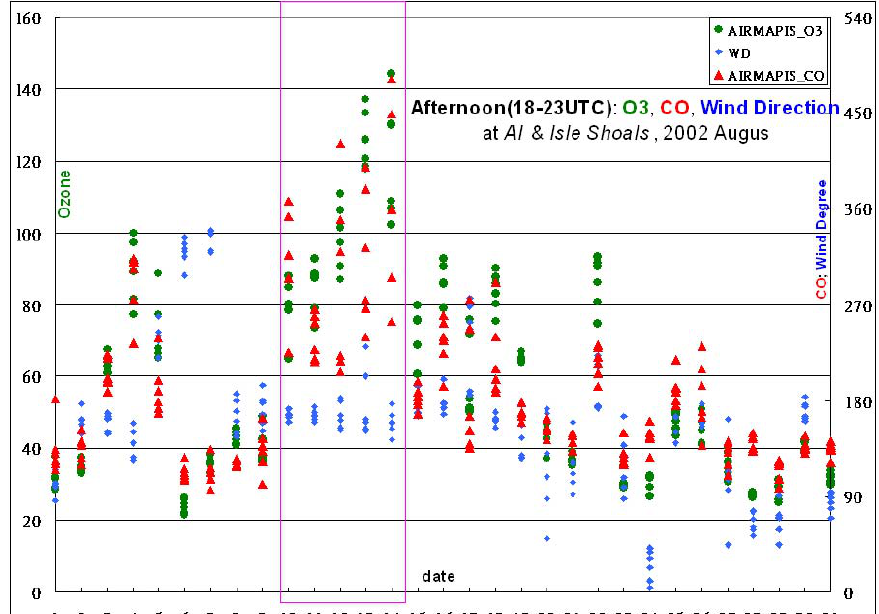
Figure 12. The observations of O (in green dots, left-axis), CO (in red dots, right-axis), 3 and wind directions (in blue dots, right-axis) during afternoon time (18–23 UTC) from 1–31 August 2002 at Appledore